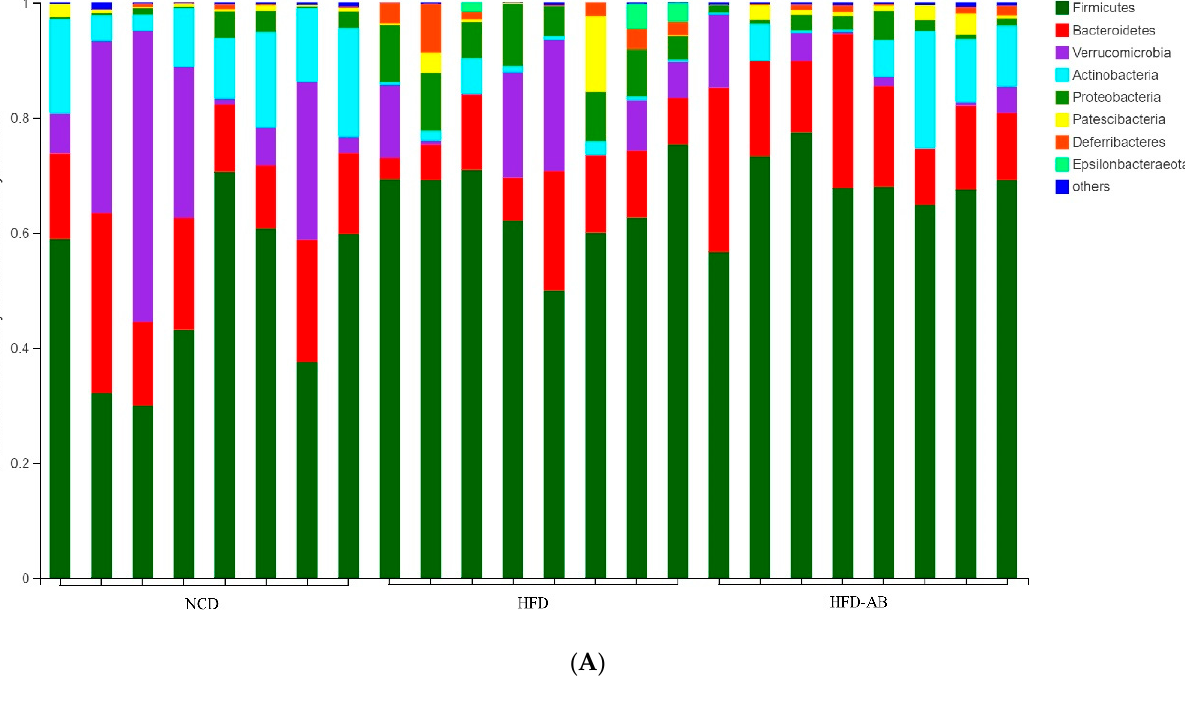
( B ) Figure 6. Cont .